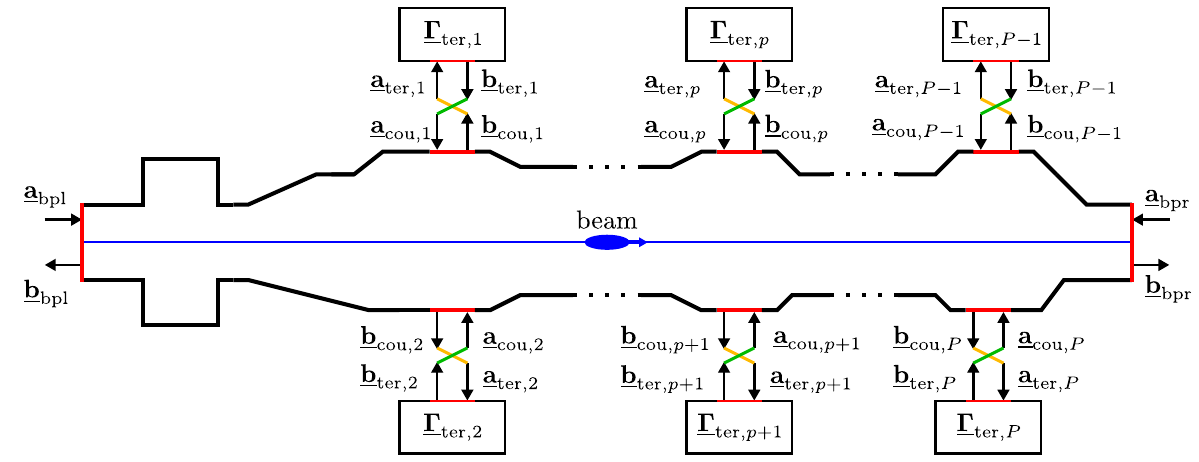
FIG. 1. Schematic representation of an accelerator structure excited by a particle beam with external termination impedances for each mode at each waveguide port. The P waveguide ports are indexed by p . The beam path is marked in blue. The beam enters the structure from the left and leaves the structure on the right. The coupling between various coupler ports and the external termination loads is indicated by green and orange lines,